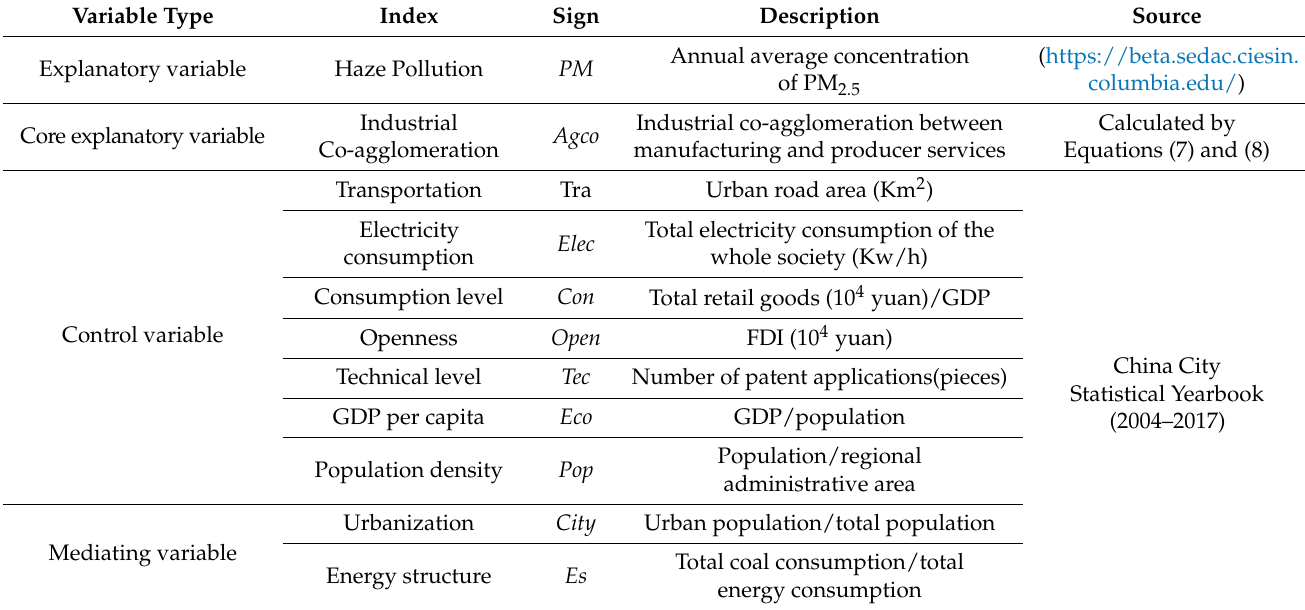
Table 1. Data Selection &